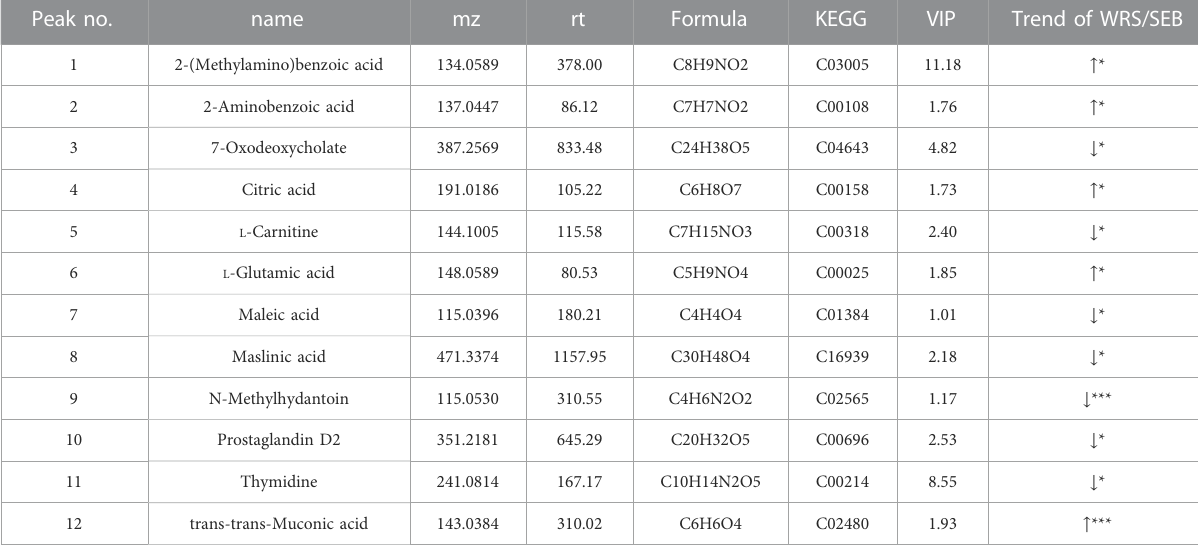
TABLE 2 12 signi fi cantly different metabolites in the feces of mice between SEB group and WRS group. Peak